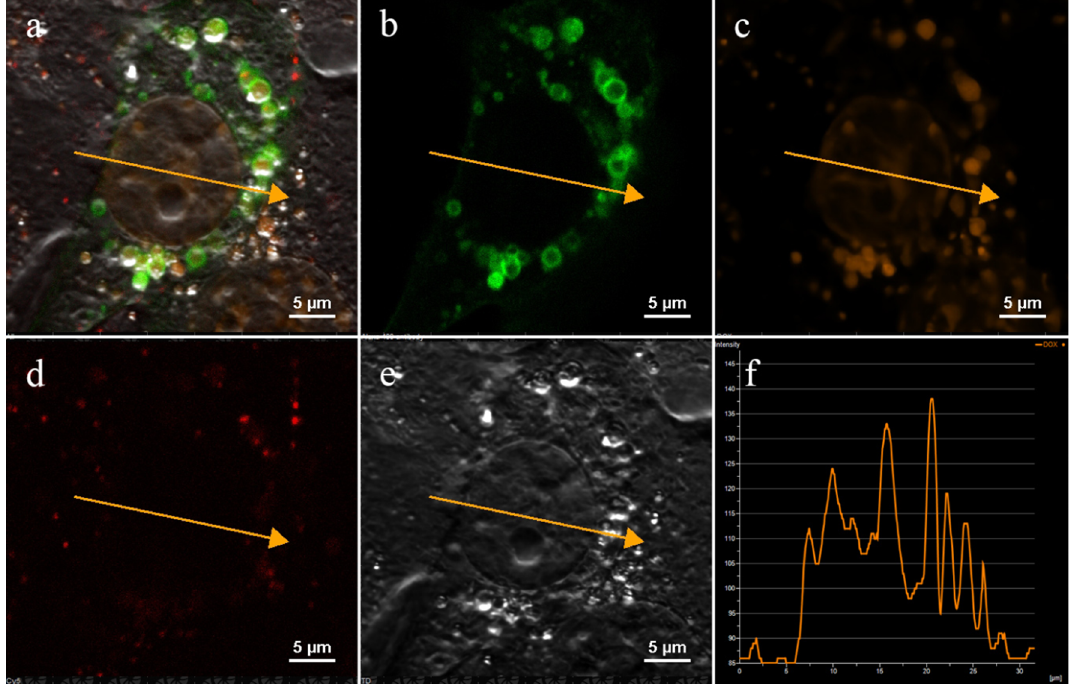
Figure 3. Intracellular localization of doxorubicin-loaded PLGA-Cy5 NP (Dox-PLGA-Cy5 NP) in 4T1 cells (60 min of incubation). ( a ) Merged image; ( b ) lysosomes—CellLight™ Lysosomes GFP, BacMam 2.0 (green channel); ( c ) Doxorubicin (orange channel); ( d ) PLGA-Cy5 NP (red channel); ( e ) cell contours—differential interference contrast (DIC); ( f ) fluorescence intensity profile along the vector (orange arrow), X-axis—µm, Y-axis—fluorescence intensity (standard units). CSLM. Scale bar—10 µm.